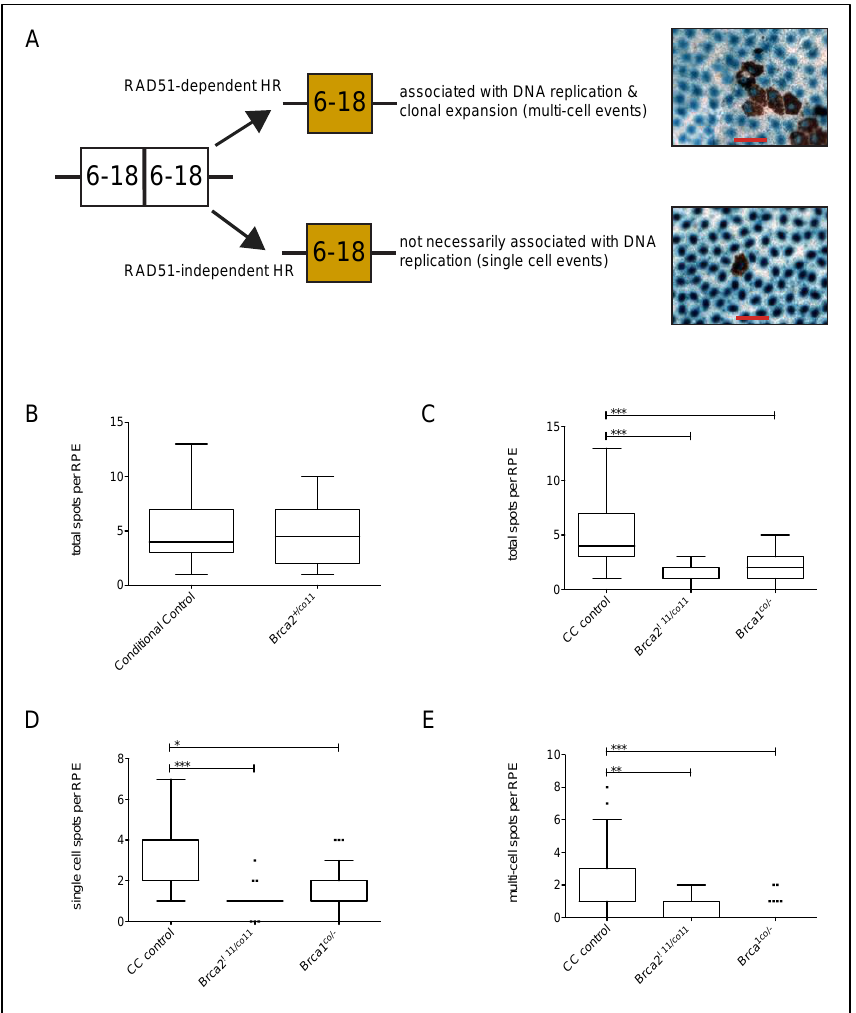
Figure 2. Full-length BRCA2 promotes high-fidelity homologous recombination. ( A ) Within the p gene results in an unpigmented eye spot (white box). Following a HR event, one of the duplicated regions is lost and pigmentation is visible (brown box). To the right are examples of a multi-cell (top) and a single-cell (bottom) reversion event (i.e., brown pigmented eye spots). Blue spots are nuclei and report Cre activity. Red bar indicates 50 µm. ( B ). To test for haploinsufficiency regarding HR, eye spots with blue nuclei from RPEs exhibiting ≥80% blue staining were analyzed for HR frequency. No significant difference ( p = 0.82; Mann–Whitney test) was detected when Brca2 delta 11 conditional heterozygosity was compared to controls. ( C ). The conditional loss of both alleles of Brca2 exon 11 results in a significant decrease ( p < 0.0001; Kruskal–Wallis test) of HR frequency compared to combined conditional (CC) controls and is similar to the conditional loss of Brca1 (see Table 1 and text for details). Only those eye spots with blue nuclei from RPEs exhibiting ≥ 80% blue stain were used for analysis, and data are represented as a Tukey box and whisker plots (*** p < 0.001). The frequency of single-cell ( D ) and multi-cell ( E ) reversion events were plotted for eye spots with blue nuclei from RPEs exhibiting ≥ 80% blue staining from CC control and BRCA2 and BRCA1 experimental animals. Both single- and multi-cell events in the BRCA2 experimental group were significantly decreased compared to control ( p < 0.0001; Kruskal–Wallis test). Data are represented as a Tukey box and whisker plots with the middle line representing the median, the box representing the inter-quartile range (i.e., 25th and 75th percentiles) and the whiskers the largest and smallest values not determined to be outliers from all data points within each comparison (* p < 0.05, ** p < 0.01, *** p <